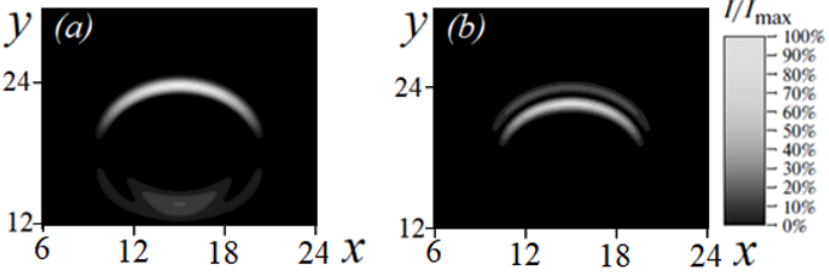
Fig. 2. I =| E | 2 at t =5.0 (2D view): (a) u =0.01; (b) u =0.1. All values in relatively